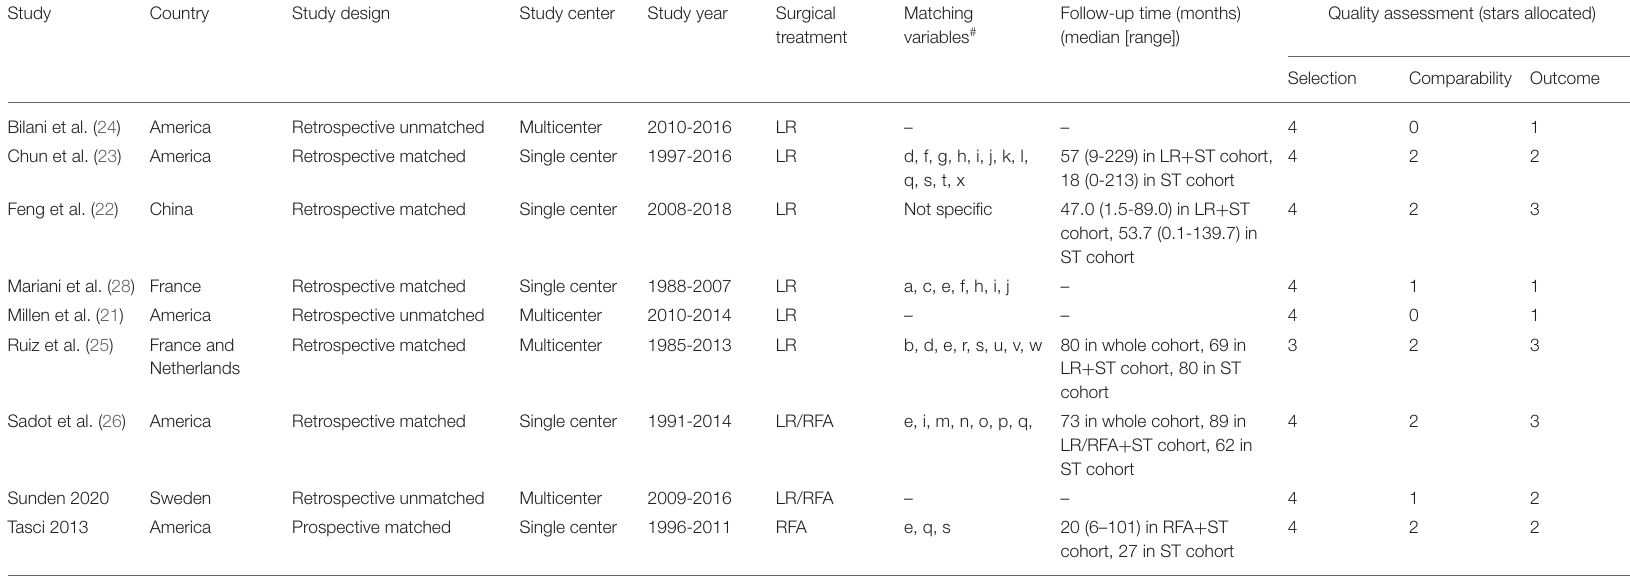
# Matching variables: Demographics and time interval: a) age at diagnosis of breast cancer, b) age at diagnosis of liver metastases, c) year of breast cancer diagnosis, d) year of liver metastases diagnosis, e) time between breast cancer diagnosis and first liver metastasis. Primary breast tumor: f) TNM stage, g) tumor grade, h) histology, i) ER status, j) PR status, k) HER2 status, l) resection of primary tumor, m) type of breast surgery, n) adjuvant chemotherapy after breast surgery, o) adjuvant radiotherapy after breast surgery, p) targeted therapy. Breast cancer liver metastases: q) number of liver metastases, r) single or multiple metastasis, s) size of liver metastases, t) synchronous liver metastases, u) chemotherapy after diagnosis of liver metastases, v) hormonal therapy after diagnosis of liver metastases, w) targeted therapy after diagnosis of liver metastases, x) best RECIST response to first-line systemic therapy. LR, liver resection; ST, systemic treatment; RFA, radiofrequency